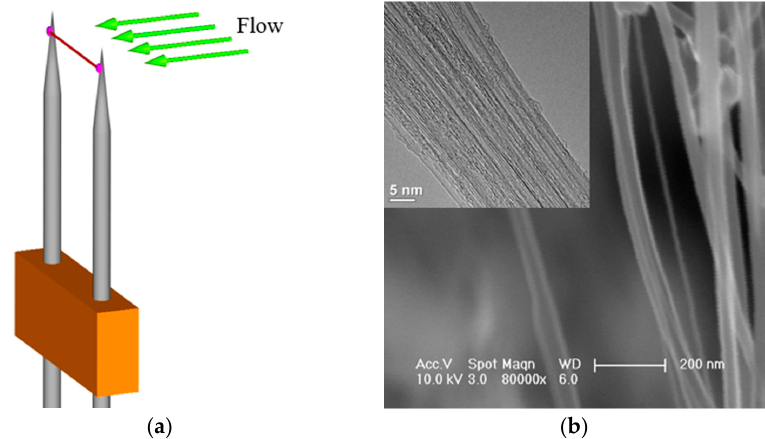
Figure 1. ( a ) Schematic illustration of an HWA; ( b ) SEM image of a DWCNT strand. The inset is a HRTEM image.